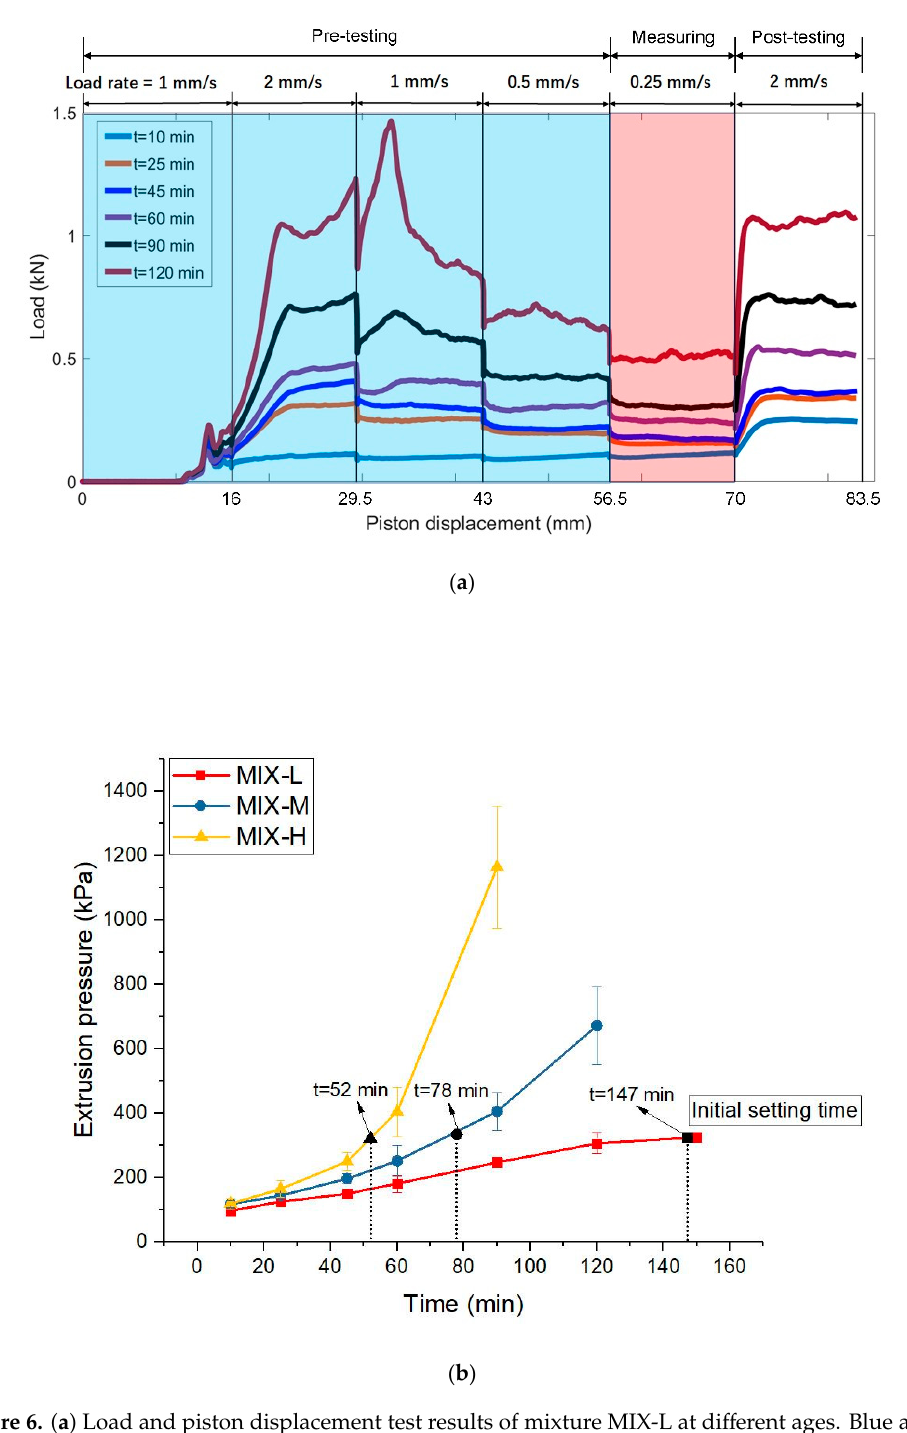
Figure 6. ( a ) Load and piston displacement test results of mixture MIX-L at different ages. Blue area – the pre-test process for reaching the dynamic status; red area – the test process for taking the average value. ( b ) Comparison of extrusion pressures (under 0.25 mm/s of piston rate) between mix designs at different ages.